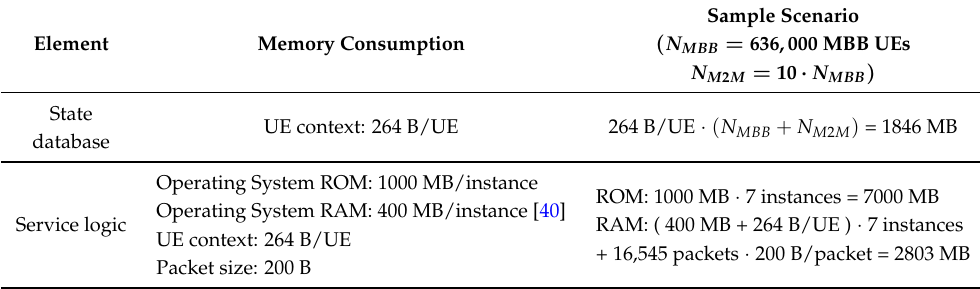
Table 6. Memory consumption estimation (UE context extracted from